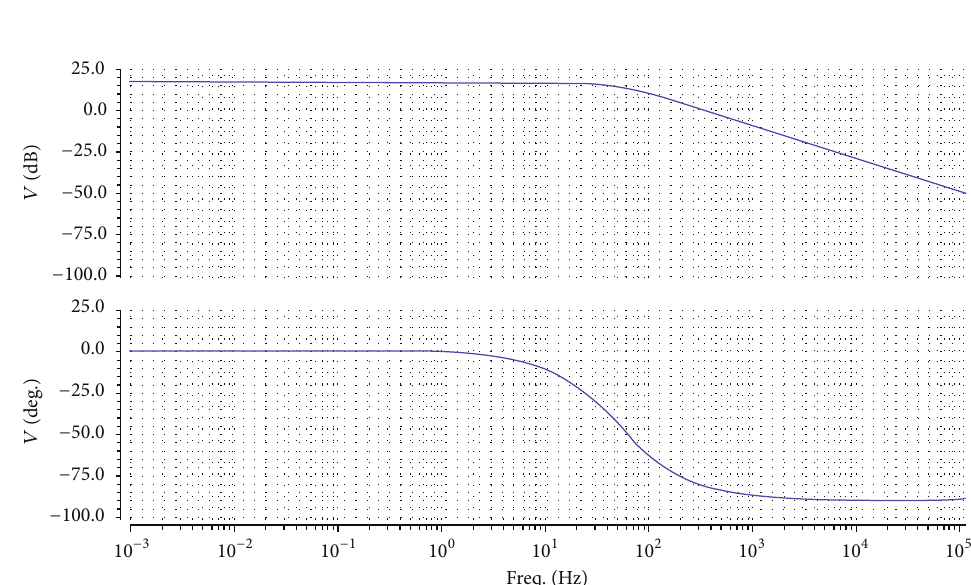
Figure 12: Frequency response of battery charger.